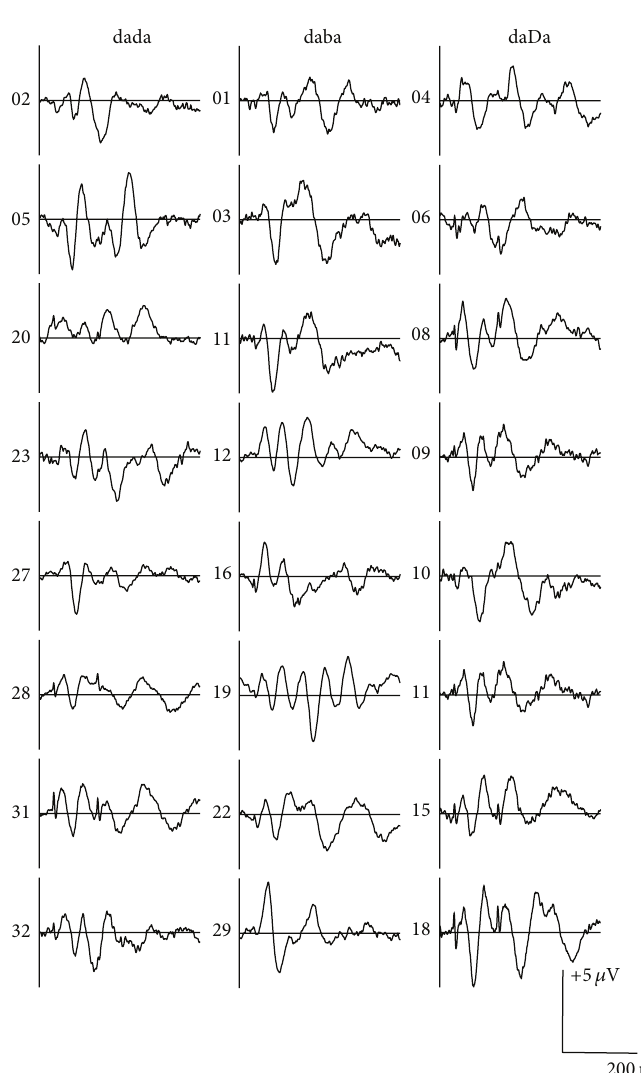
Figure 5: Individual waveform elicited to /dada/, /daba/, and /daDa/ at C3 for the 24 infants described in Figure 4.